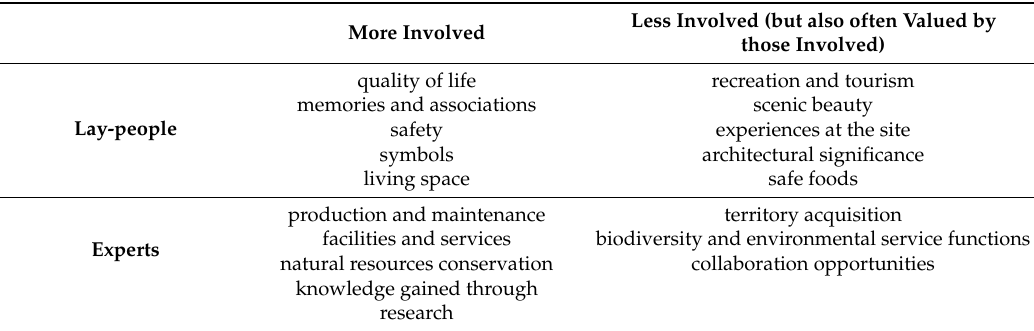
Table 1. Items of interests between the di ff erent levels of involvement and expertise (developed from Selman (2006) and Parr et. al, 2007